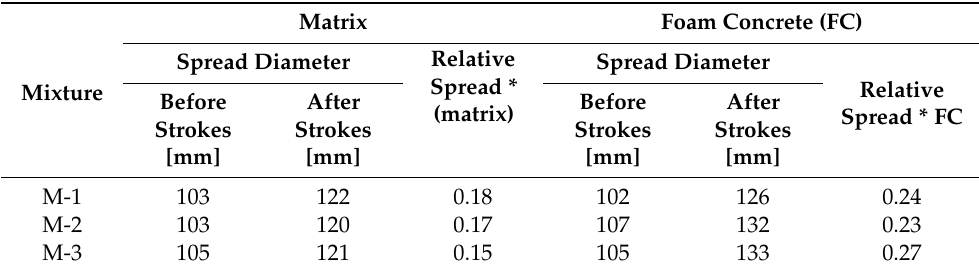
Table 6. Foam concrete properties in the fresh